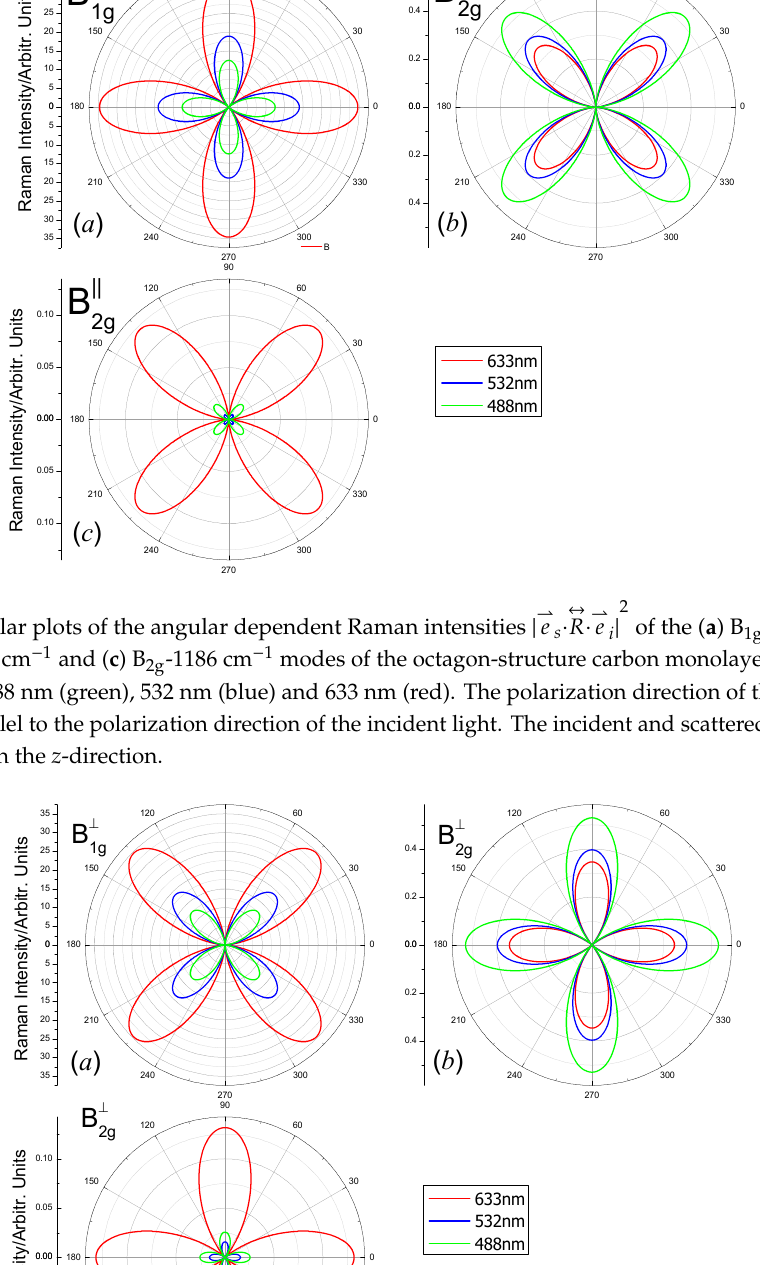
(cid:2870) of ( a ) B 1g ‐ 1112 (cid:2870) ↔ 2 (cid:42) (cid:42) of ( a ) B 1g ‐ 1112 e s · R · e i | of ( a ) B 1g -1112 cm − 1 ,